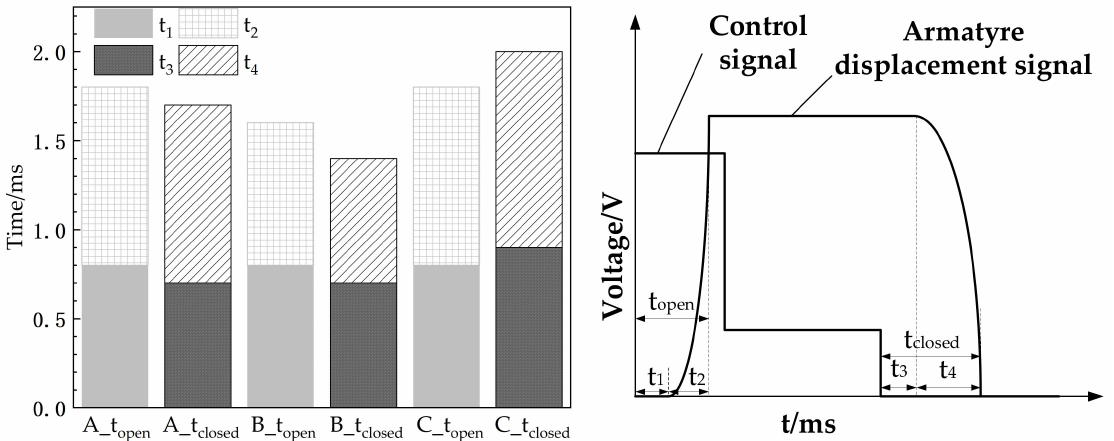
Figure 21. Comparison group solenoid valve response time.